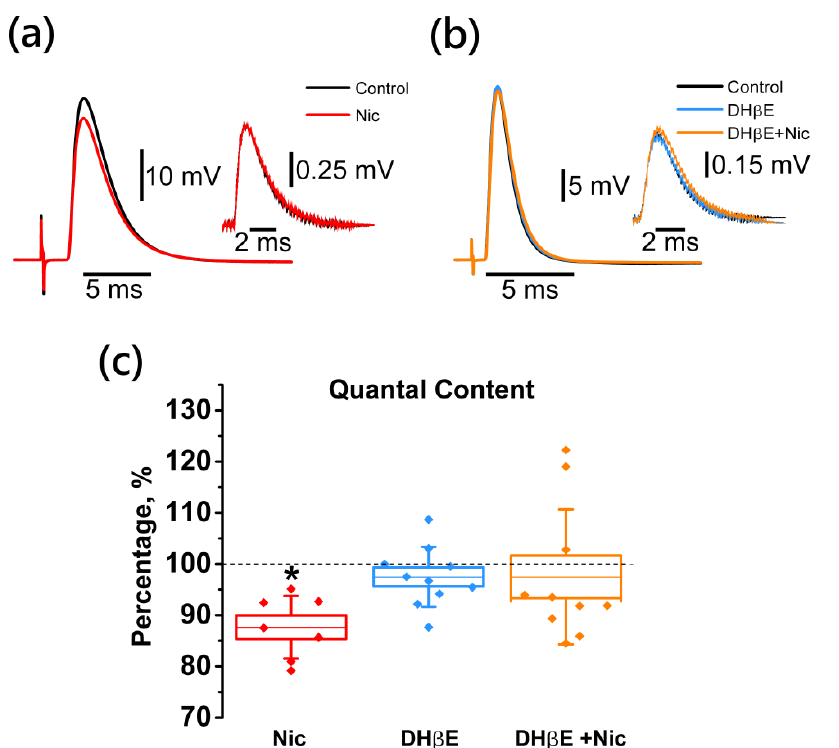
Figure 2. Nicotine inhibits the evoked release of ACh quanta (quantal content, QC) by activating nNAChRs. Panels on the top are representative traces of EPP and mEPP (50 signals averaged) in separate experiments with nicotine application (Nic, 10 µM; ( a )), and nicotine application after pretreatment with the neuronal cholinergic receptor antagonist DHβE (1 μM; ( b )). ( c ) Results are expressed as mean ± SEM and SD of QC, as percentages with nicotine ( n = 7), DHβE ( n = 9), and DHβE plus nicotine ( n = 9) applications versus control. Asterisks (*) indicate significant effects ( p < 0.05, one-way repeated ANOVA test with Tukey’s post-hoc comparison).